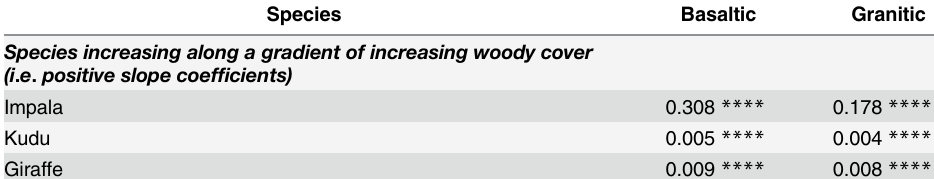
Table 2. Slope coefficients of herbivore density (individuals.km -2 ) along a gradient of increasing woody cover (e.g. for a 10% increase in woody cover on the basalts, the impala density increase by 3 individuals.km -2 whilst the zebra density decrease by 0.6 individuals.km -2 ). This illustrates that brows- ers increase with increasing woody cover, whilst most grazers decrease. ( **** 0.01% significance level; *** 0.1% significance level; ** 1% significance level; * 5% significance level; when applying a Bonferroni correc- tion for 24 tests, only species indicated as significant at the (cid:3) 0.1% level will remain significant at the 5% level).